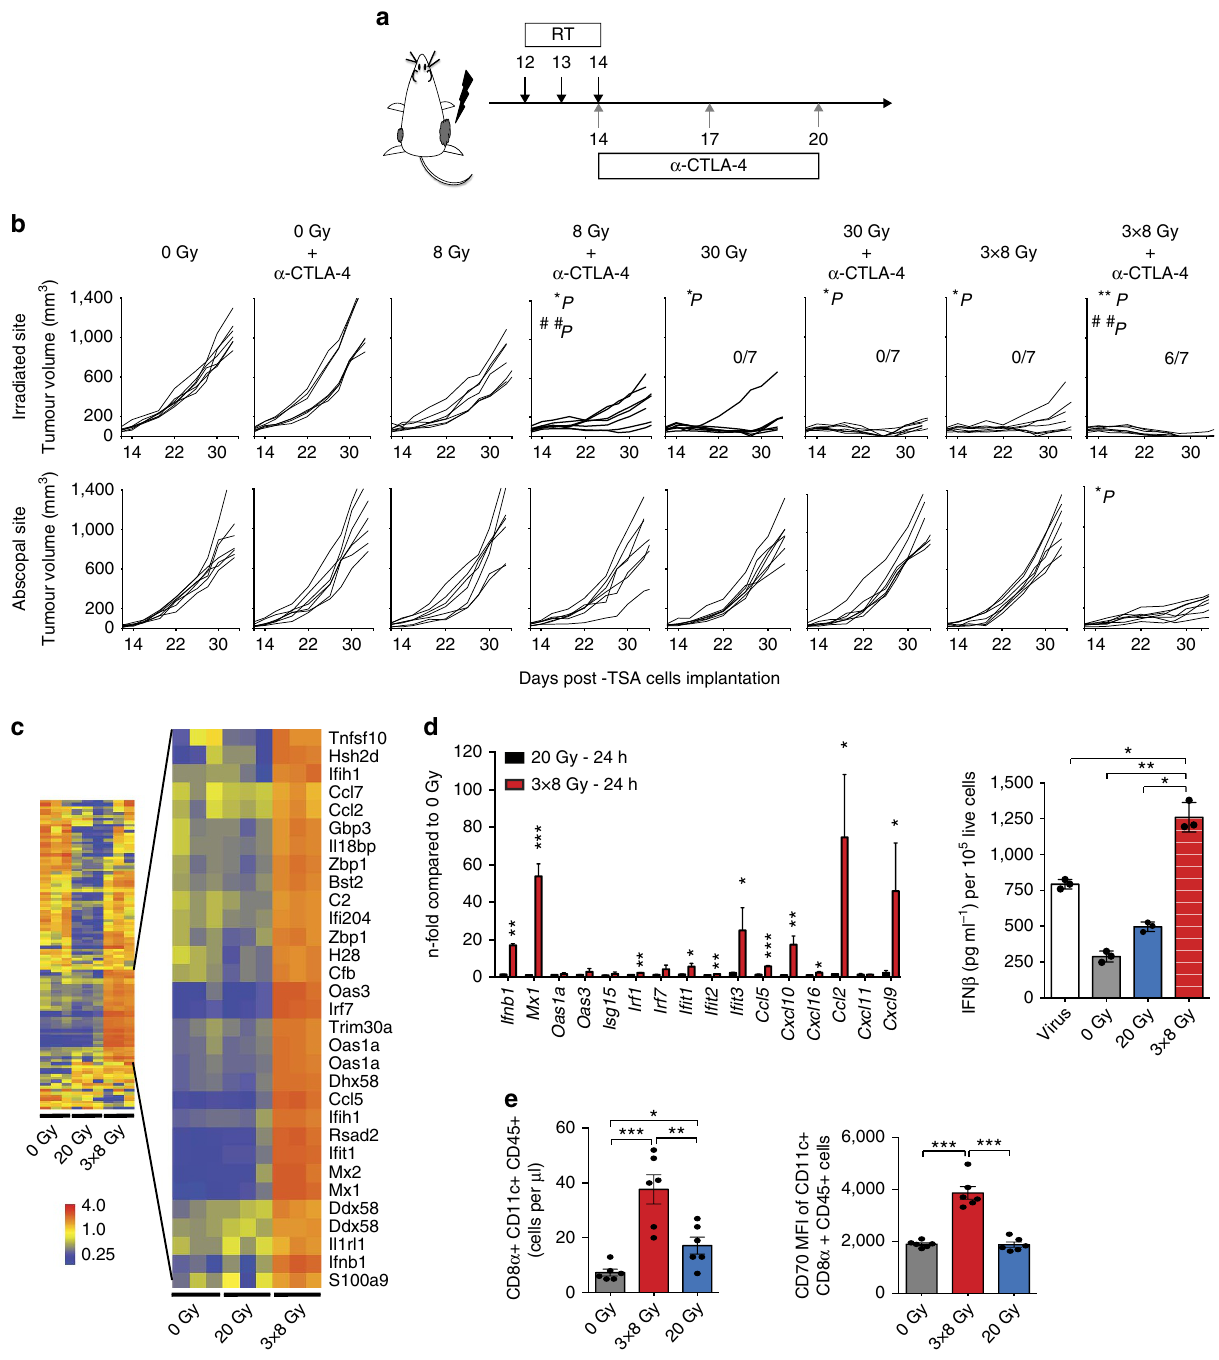
Figure 1 | Radiation-induced activation of type-I interferon pathway correlates with radiation’s ability to induce abscopal responses in combination with anti-CTLA4. ( a , b ) In mice with bilateral TSA tumours one tumour was irradiated (RT) and mice received anti-CTLA4 antibody as indicated ( a ). Growth of irradiated and abscopal tumours in mice treated with 0 Gy, 0 Gy þ anti-CTLA4, 8GyX1, 8GyX1 þ anti-CTLA4, 30GyX1, 30GyX1 þ anti- CTLA4, 8GyX3 and 8GyX3 þ anti-CTLA4. Ratios indicate the number of mice free from the irradiated tumour. (Duplicate; asterisks indicate P values for the comparison of irradiated tumours in each group versus 0 Gy controls, * P o 0.05; ** P o 0.005; hashs indicate P values for the comparison of tumours treated or not with anti-CTLA4 within each radiation level, ## P o 0.005; two-way ANOVA; n ¼ 7). ( b ). ( c ) Heat map of gene expression in TSA tumours 24h after radiation in vivo ( n ¼ 3). ( d ) qRT-PCR ( n ¼ 4) and IFN b secretion ( n ¼ 3) 24h after in vitro irradiation of TSA cells (Triplicate; * P o 0.05; ** P o 0.005; *** P o 0.0005: t -test). ( e ) Number of CD11c þ CD8 a þ DCs infiltrating TSA tumours 5 days after irradiation and CD70 mean fluorescence intensity (MFI) gated on CD11c þ CD8 a þ cells ( n ¼ 5). (Duplicate; * P o 0.05; ** P o 0.005; *** P o 0.0005: t -test). All data are mean ± s.e.m. significantly higher levels of double-stranded DNA (dsDNA) doses of radiation (Fig. 3a). The exonuclease Trex1 plays an were present in the cytoplasmic fraction of TSA cells treated with essential role in clearance of DNA from the cytoplasm of both one or three 8 Gy radiation doses than with 20 or 30 Gy single haematopoietic and non-haematopoietic cells 16–18 , and Trex1 NATURE COMMUNICATIONS|8:15618|DOI: